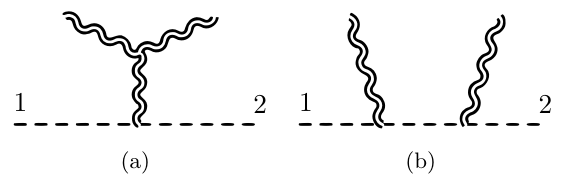
Figure 6 . Amplitudes with hard particles replaced by Goldstone